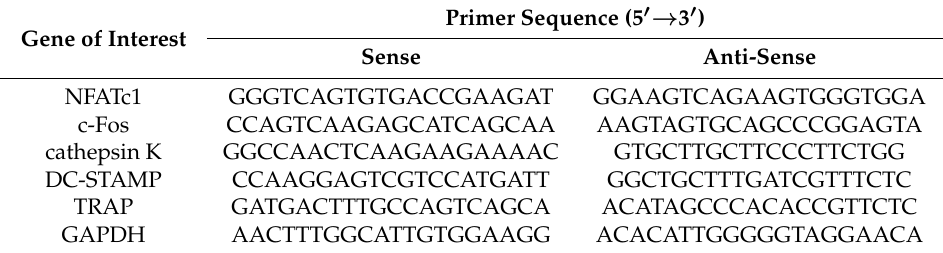
Table 1. Primer sequences used in this